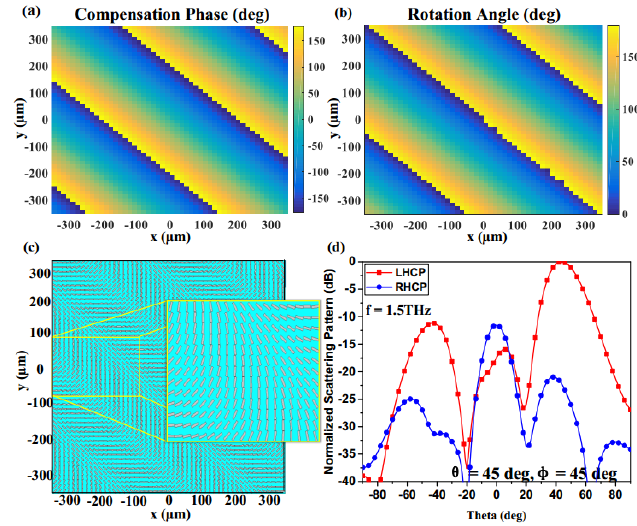
Figure 7. Simulation results for controlling the SAM of the reflected wave at ( θ , ϕ ) = (45 ◦ , 45 ◦ ): ( a ) Compensation phase pattern of the graphene metasurface; ( b ) rotation angle pattern of the graphene metasurface; ( c ) the element pattern of the metasurface; ( d ) 2D normalized scattering pattern of the graphene metasurface.